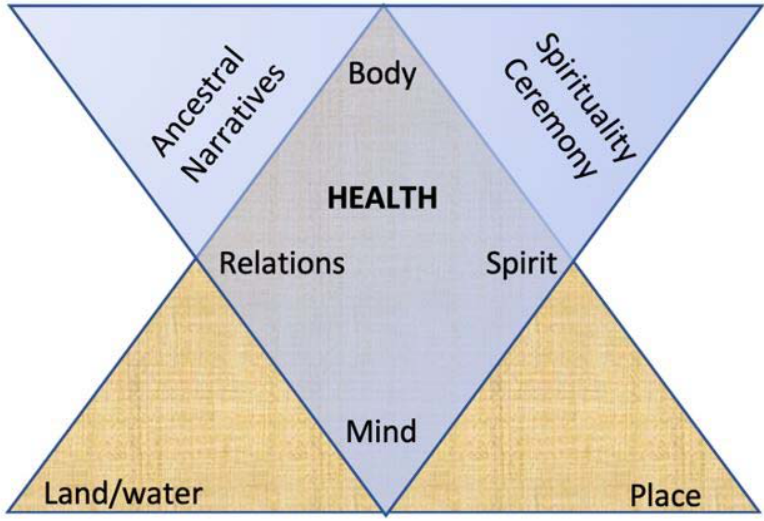
Figure 1. Uma Hochokma Figure 1. Houma Health Uma Hochokma Framework.